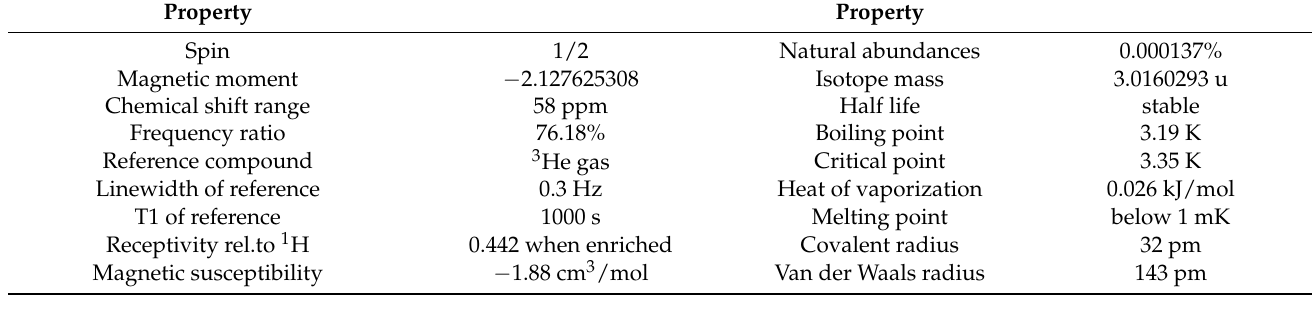
6 Table 1. Physical and magnetic properties of 3 He atoms and nuclei.